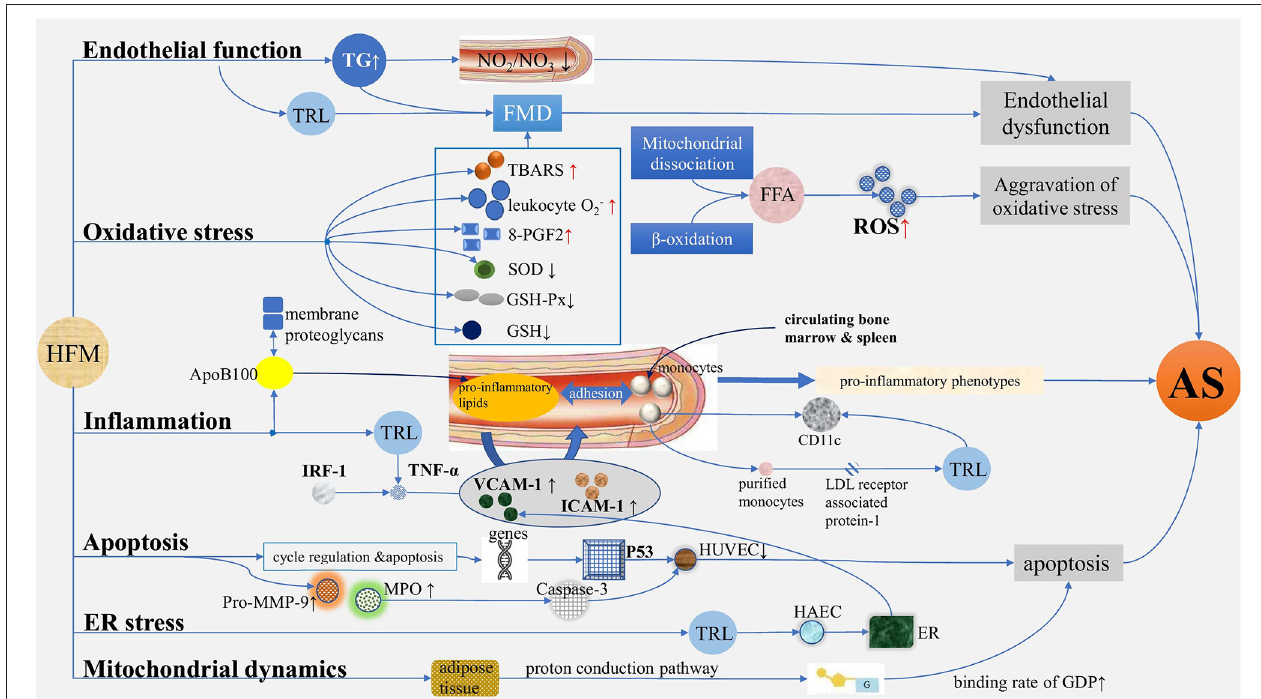
FIGURE 1 | Mechanisms of atherosclerosis induced by postprandial lipemia. (1) Endothelial function: TG increased after HFM, while serum nitrite/nitrate levels and FMD decreased, suggesting endothelium dysfunction. (2) Oxidative stress: In terms of oxidative stress, TBARS, leukocyte O − 2 , and 8-PGF2 increased, and SOD, GSH-PX, and GSH decreased after HFM. ROS are produced in large quantities due to the increased levels of free fatty acids mediated by mitochondrial dissociation and β -oxidation. (3) Inflammation: ApoB100-containing lipoproteins enter into the arterial subendothelium, thus generating proinflammatory lipids, promoting the expression of adhesion factors such as, VCAM-1 and ICAM-1, which induce the augmentation of adhesion interaction with monocytes in turn, generating proinflammatory phenotypes and AS; TRL isolated from human plasma after HFM regulated TNF- α -induced VCAM-1 expression by regulating IRF-1-dependent transcription mechanism. The expression of CD11c on monocytes increased after a meal, and the purified monocytes internalized TRL isolated from postprandial blood through LDL receptor associated protein-1, which also caused the upregulation of CD11c. (4) Apoptosis: With the relation of cell cycle regulation and apoptosis, a group of genes of HUVEC differentially expressed in serum of postprandial hyperlipidemia after a meal, causing proliferation of HUVEC, significantly decreased and may be achieved by activating p53 network; the activities of pro-MMP-9, MPO, and caspase-3 increased significantly after a meal, showing apoptosis effect. (5) ER stress: The expansion of ER was significantly increased by HAEC treated with postprandial TRL, and the production of TRL increased the adhesion of VCAM-1-dependent monocytes to inflammatory endothelium, indicating ER stress plays a role in the regulation of VCAM-1 transcription in endothelial cells during the process of AS. (6) Mitochondrial dynamics: The binding rate of GDP increased by 85% after HFM, and the increase was the largest in early postprandial period. TG, triglyceride; HFM, high-fat meal; FMD, flow-mediated vasodilation; TBARS, thiobarbiturate reactants; 8-PGF2, 8-external prostaglandin F2; SOD, superoxide dismutase; GSH-PX, glutathione peroxidase; ROS, reactive oxygen species; VCAM-1, vascular cell adhesion molecule-1; ICAM-1, intercellular adhesion molecule-1; AS, atherosclerosis; TRL, TG-rich lipoprotein; LDL, low-density lipoprotein; HUVEC, human umbilical vein endothelial cell; ER, endoplasmic reticulum; HAEC, human aortic endothelial